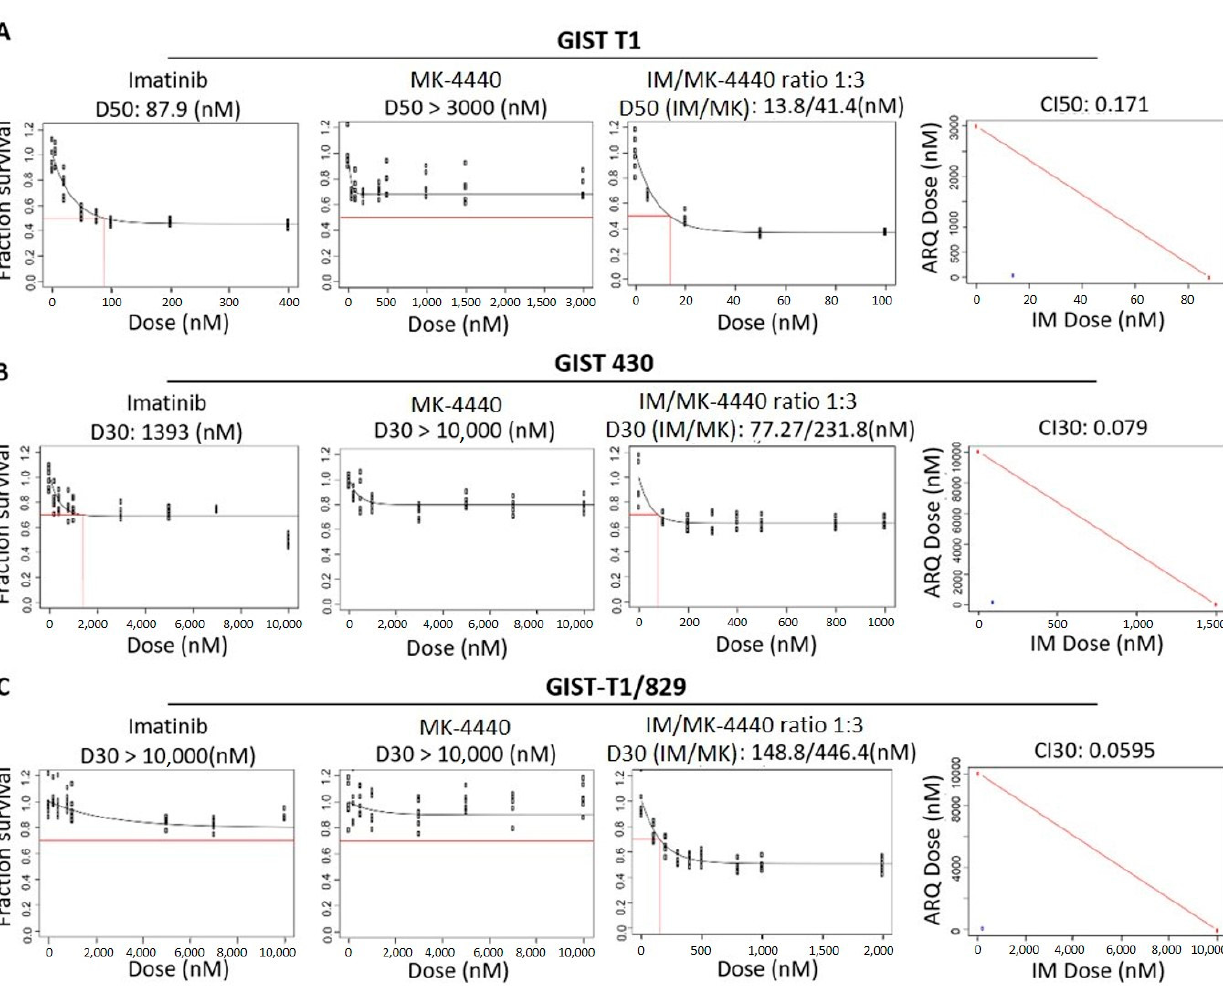
Figure 1. MK-4440 and IM have enhanced combination on in vitro GIST cell growth. Panels 1 & 2, dose-response curves for single agents (IM, MK-4440) in GIST-T1 ( A ), GIST430 ( B ) and GIST-T1/829 ( C ) cell lines. Values represent the mean of survival compared to control cells ( n = 6). Panel 3, dose-response curve representing increasing series of combinations in GIST-T1 ( A ) GIST430 ( B ) and GIST-T1/829 ( C ) cell lines. Red box indicates estimation of LD50 (GIST-T1, ( A )) or LD30 (GIST430, ( B ) and GIST-T1/829, ( C )) concentration for combination of drugs. Panel 4, single point (blue) on isobole curve for 50% kill (GIST-T1, ( A )) or 30% kill (GIST430, ( B ) and GIST-T1/829, ( C )). Red line indicates 50% (GIST-T1) isobole or 30% isobole for GIST430 and GIST-T1/829 for strictly additive effect. CILD50 in GIST-T1 is 0.171 and CILD30 in GIST430 and GIST-T1/829 are 0.079 and 0.0595, respectively, all found within the synergistic triangle.